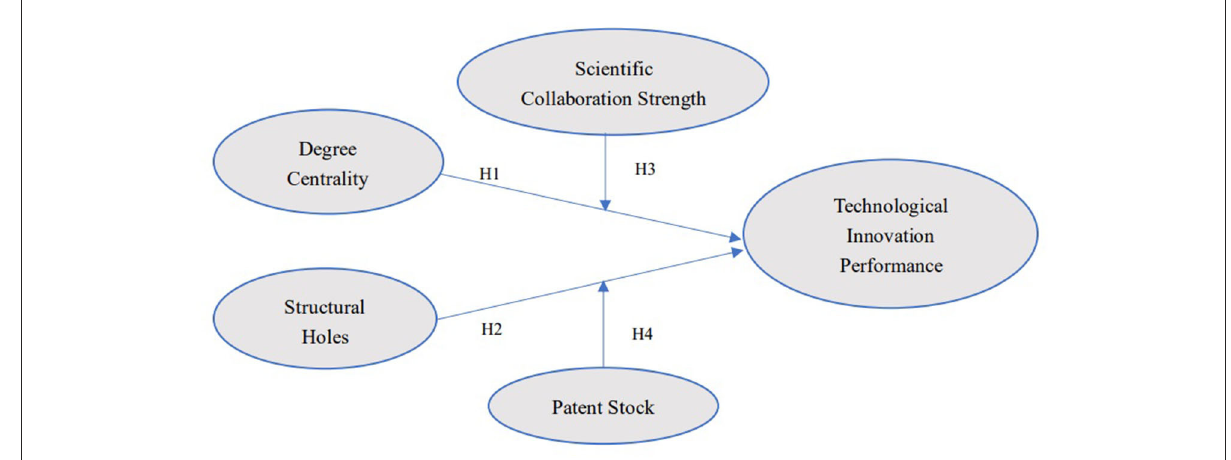
FIGURE1 Conceptual framework.